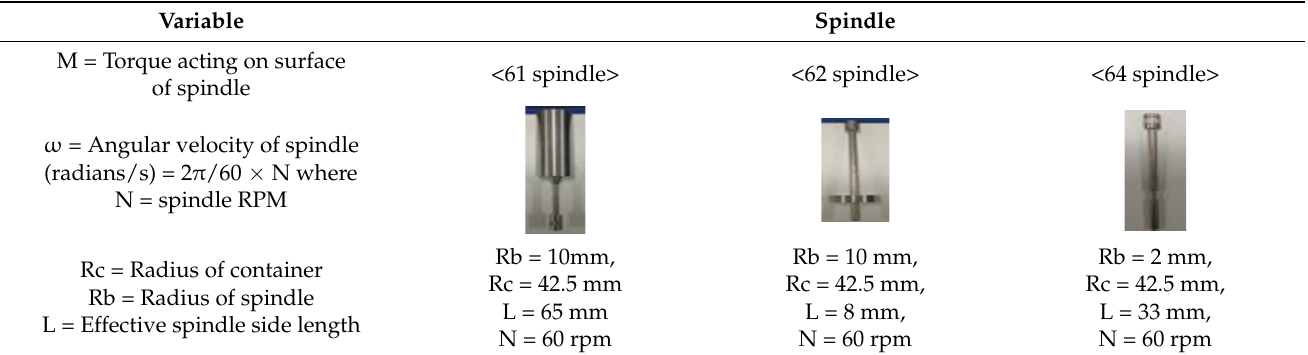
Table 4. Viscosity value measurement variable, spindle specification.